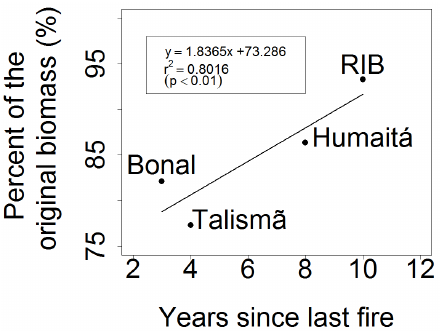
Figure 6. Relationship between percent of the original biomass (%) and years since last fire based on LiDAR data. Black circles correspond to each area of